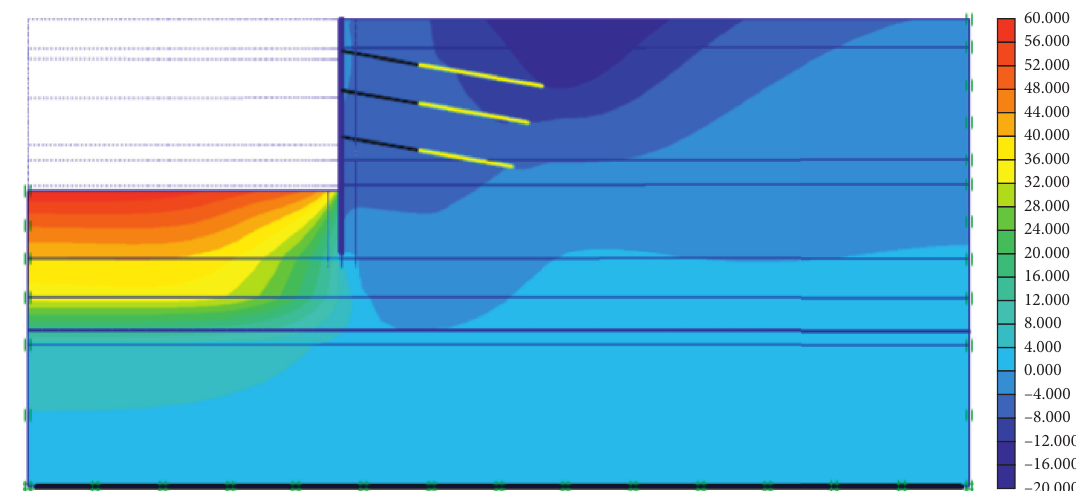
Figure 9: Vertical displacement